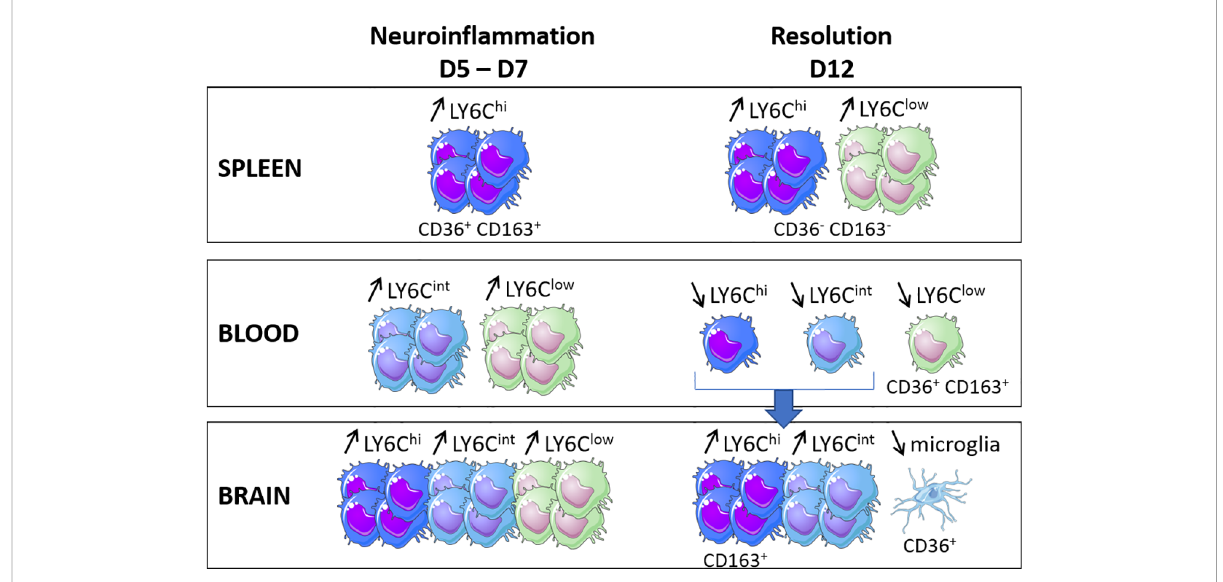
FIGURE 4 Schematic illustration of the main results obtained for the evolution of the percentages of the monocyte subpopulations in the three compartments (i.e., the spleen, blood and brain) and their CD36 and CD163 receptor expression phenotypes during the two major phases of the infection kinetics (neuroin fl ammation and its resolution) in a model of experimental cerebral